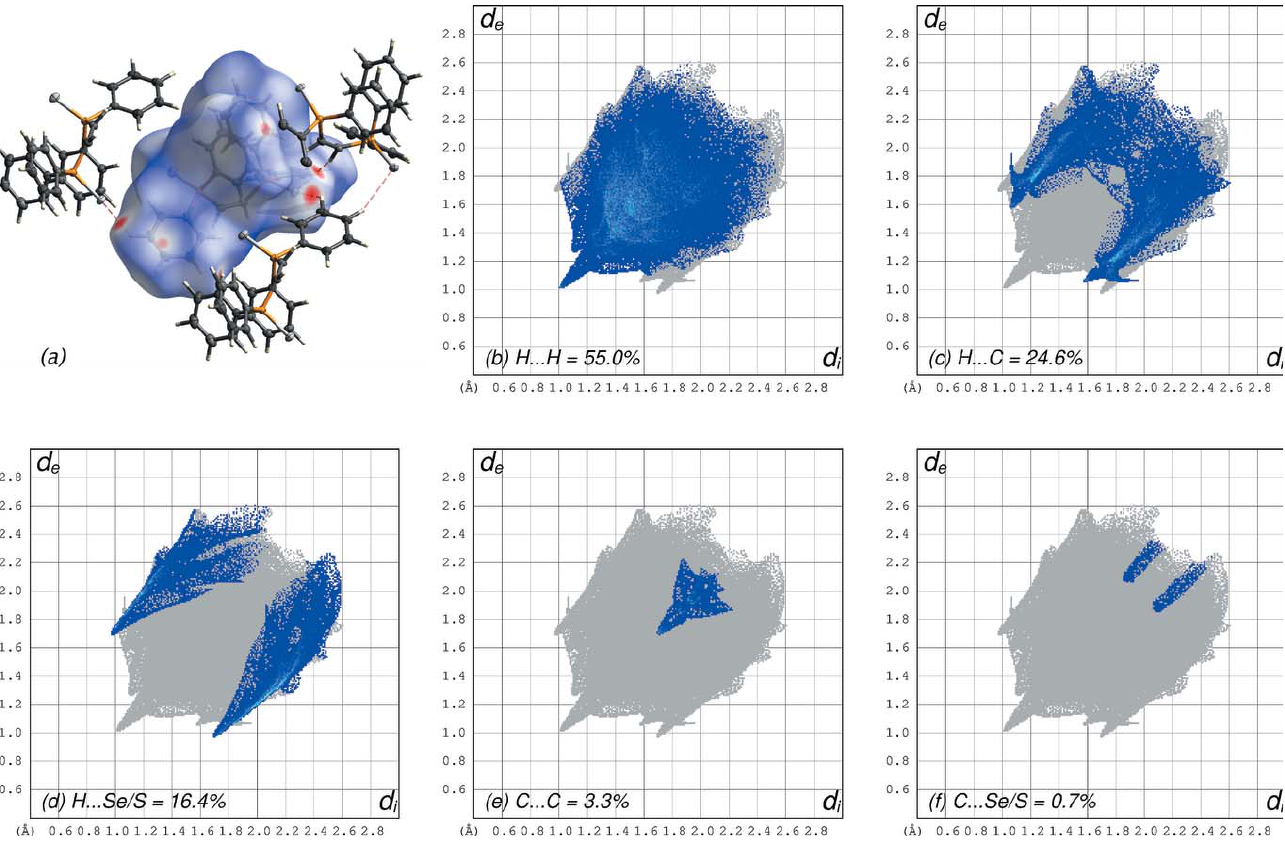
Figure 7 ( a ) A Hirshfeld-surface plot mapped over d norm for the final model. Red spots and dashed lines highlight close contacts between C—H groups and the Se/ S sites (see also Table 5). ( b ) Hirshfeld-surface fingerprint plot showing H (cid:6)(cid:6)(cid:6) H contacts (55.0%). ( c ) Hirshfeld-surface fingerprint plot showing H (cid:6)(cid:6)(cid:6) C contacts (24.6%). ( d ) Hirshfeld-surface fingerprint plot showing H (cid:6)(cid:6)(cid:6) Se/S contacts (16.4%). ( e ) Hirshfeld-surface fingerprint plot showing C (cid:6)(cid:6)(cid:6) C contacts (3.3%). ( f ) Hirshfeld-surface fingerprint plot showing C (cid:6)(cid:6)(cid:6) Se/S contacts